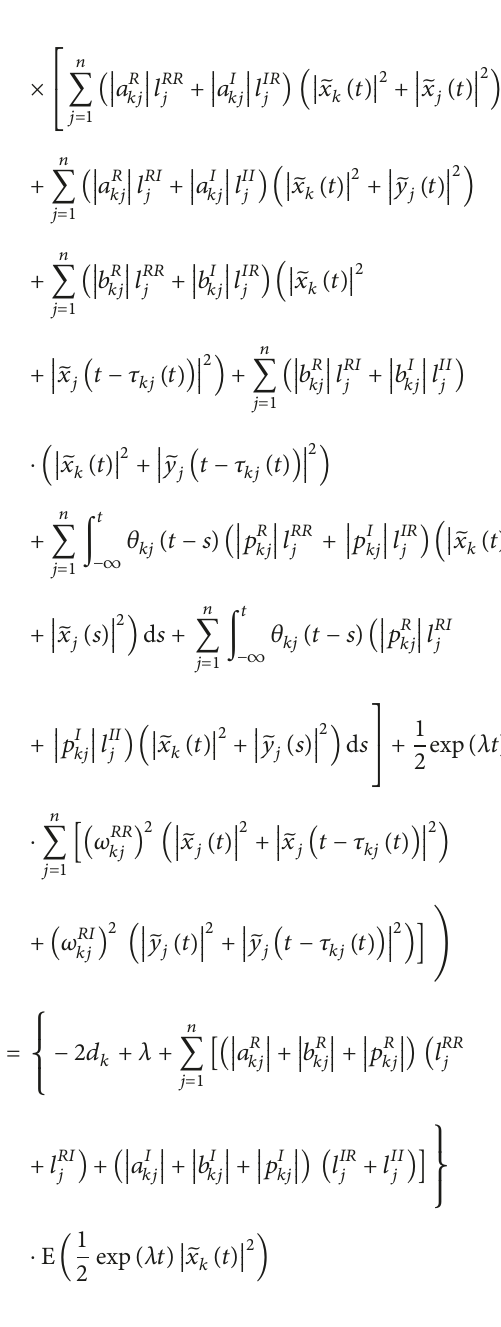
Figure 8: State norm curves of